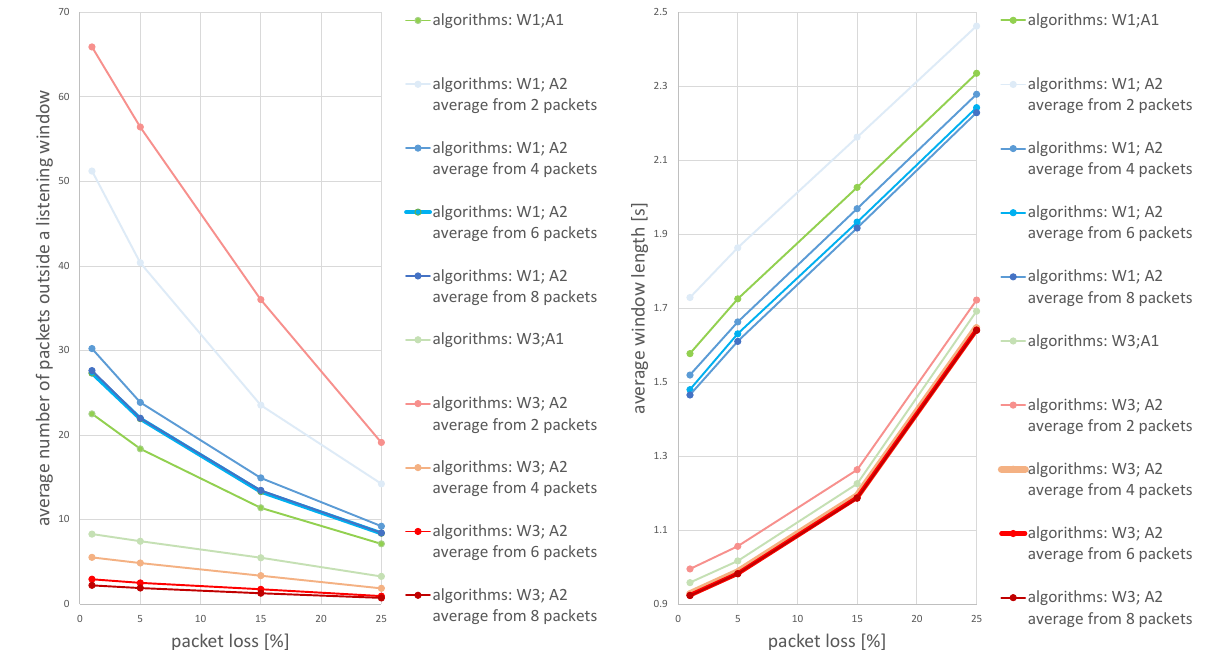
Figure 12. The degree of improvement brought by the algorithm (W3) in relation to the algorithm (W1) —algorithm (W2) is omitted in this statement because it did not bring a significant